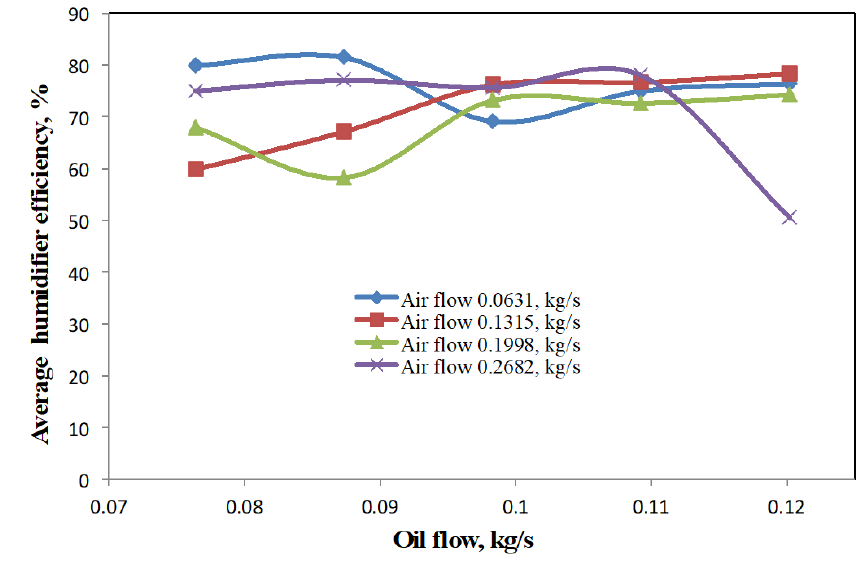
Figure 13. HD average input energy at different air and oil flow rates.